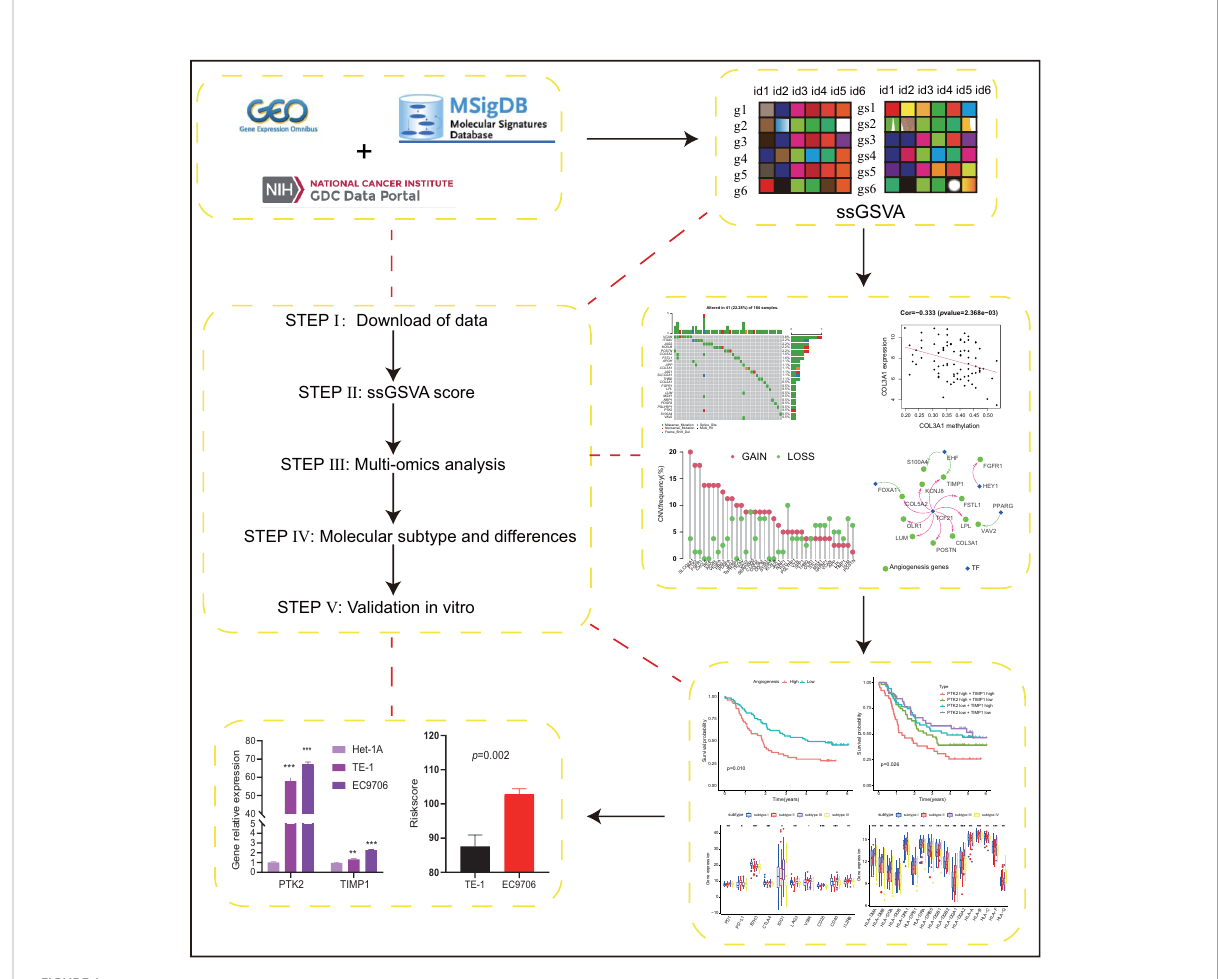
FIGURE 1 Schematic illustration of our research,subtypes. (p values were showed as: *p < 0.05; **p < 0.01; ***p < 0.001. ****p <